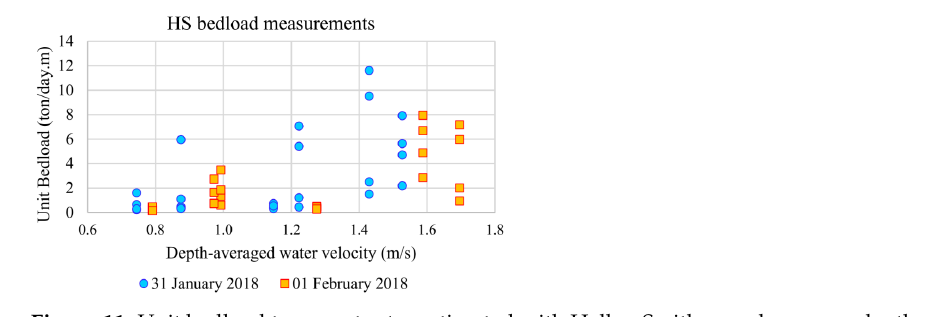
Figure 11. Unit bedload transport rates estimated with Helley-Smith sampler versus depth-averaged